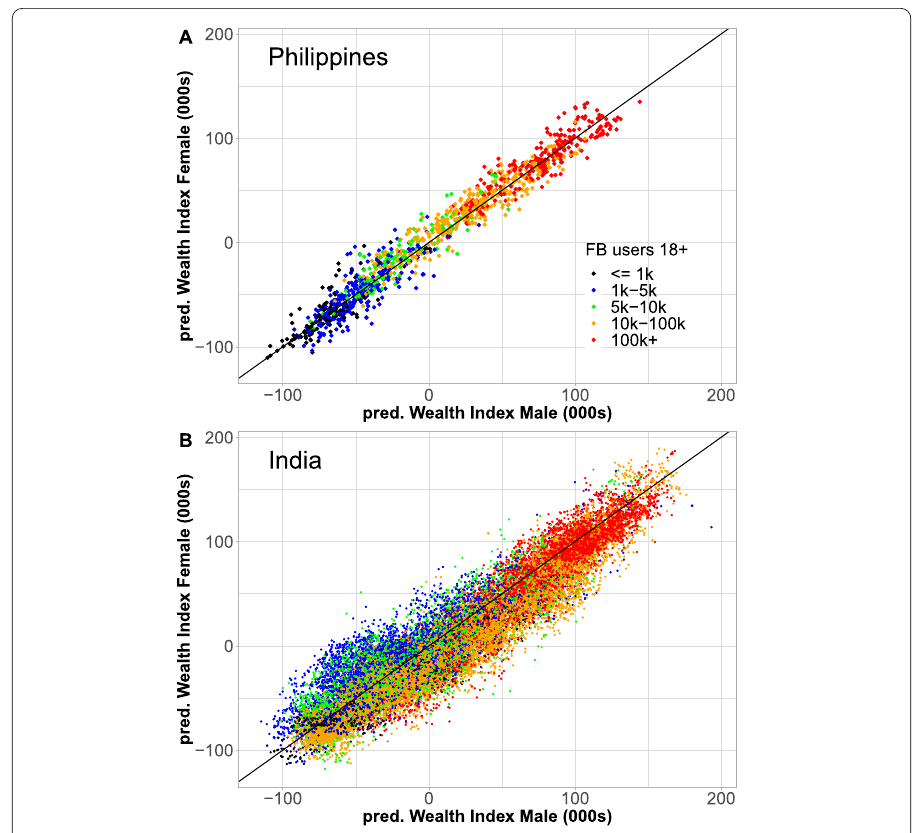
Figure 4 Gender disaggregated predictions. Gender disaggregated predictions (male vs. female) for DHS clusters in the Philippines ( A ) and India ( B ); plotted line is the diagonal. Predictions were made by applying the tree model with Facebook features, log population density and regional indicator variables (fitted on data for the 18+ user group) to disaggregated data collected separately for each gender. Predictions shown for the 1175 clusters in the Philippines and 27,271 clusters in India where there was an estimated non-zero Facebook user population for both males and females aged